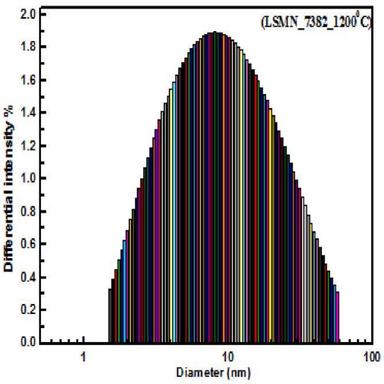
Particle size distribution of LSMN7382 nanopowder by DLS method.